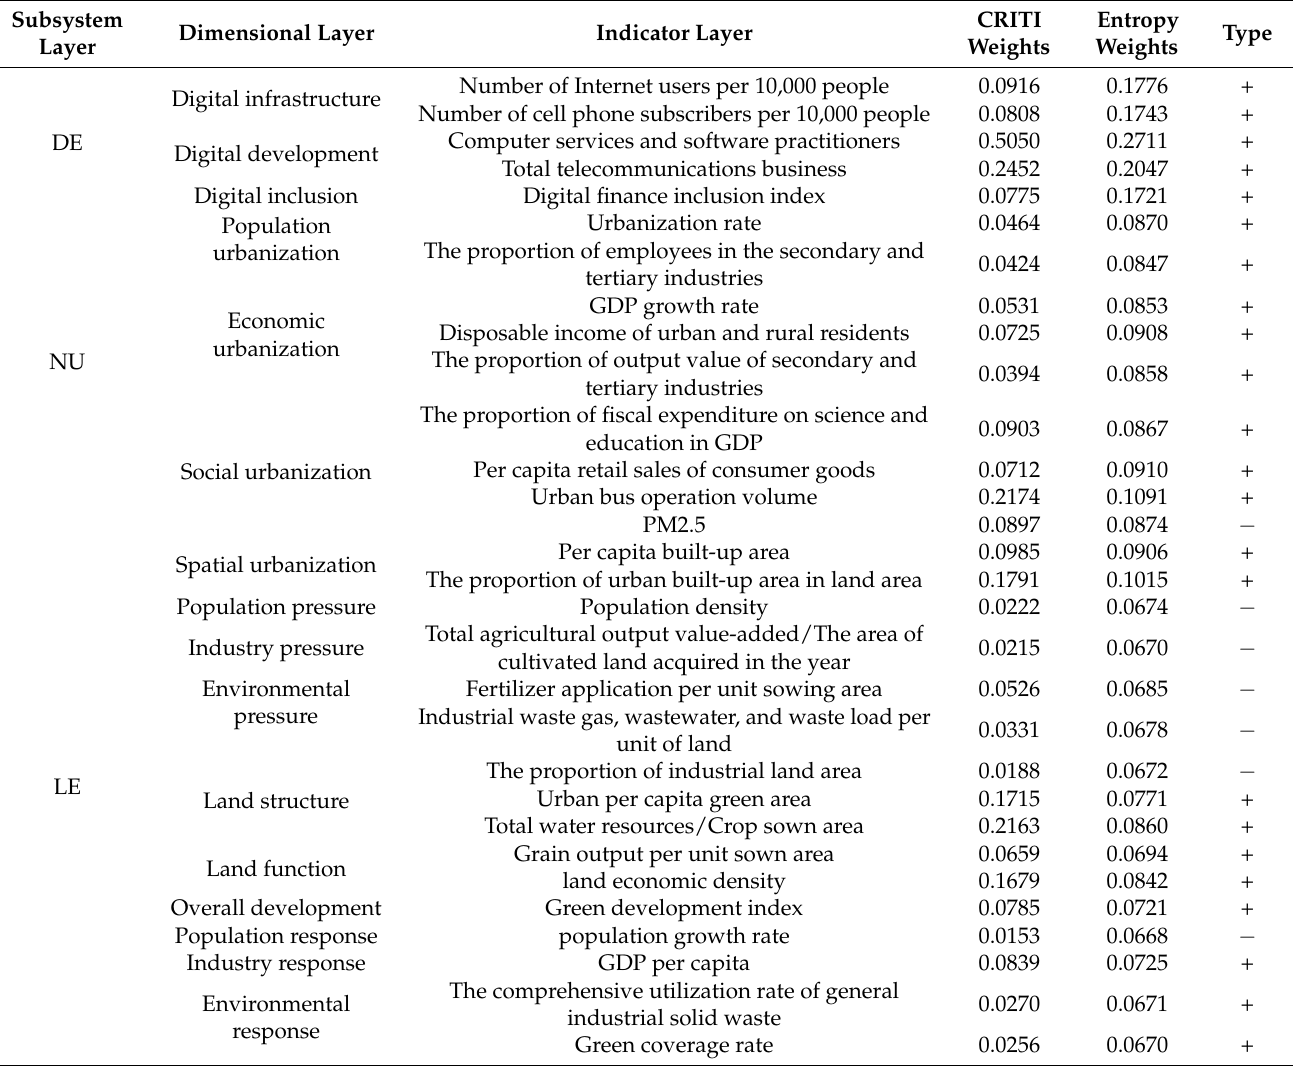
Table 1. Evaluation indicators and weights of DE–NU–LE development in the Yangtze River